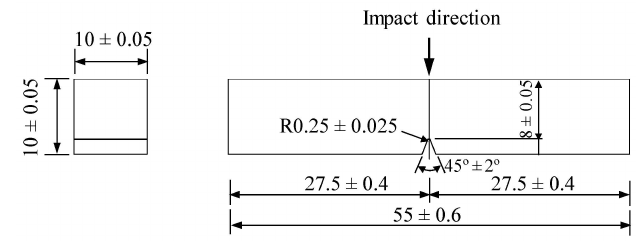
Figure 7. Charpy impact test specimen.